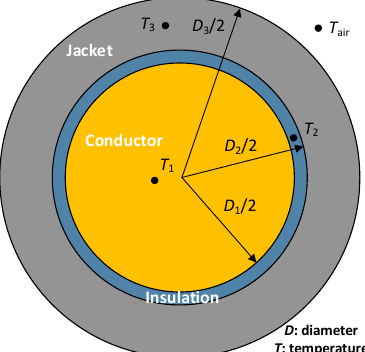
Figure 1. Cable layout including the copper core, the inner XLPE insulation layer and the outer PVC jacket. PVC